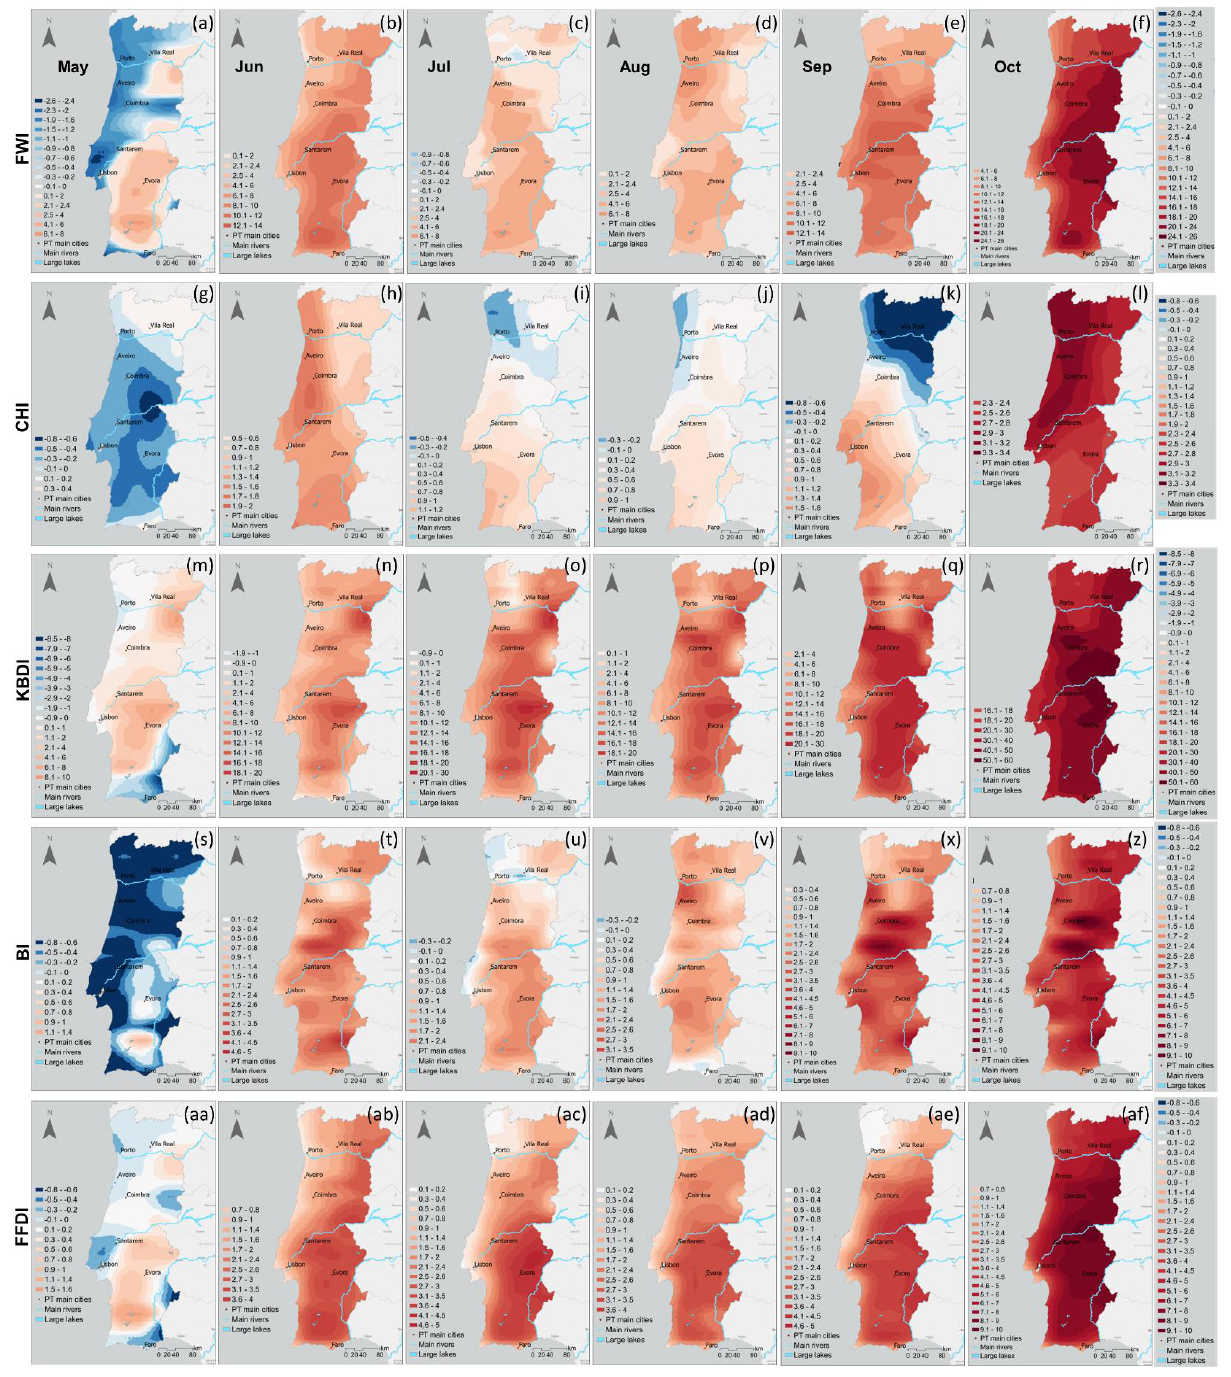
Figure 3. Spatial distribution of the statistically significant (at a 5% significance level) monthly mean anomalies for FWI, CHI, KBDI, BI, and FFDI between 2001–2021 (reference period), respectively by row and 2017 for ( a , g , m , s , aa ) May, ( b , h , n , t , ab ) June, ( c , i , o , u , ac ) July, ( d , j , p , v , ad ) August, ( e , k,q , x , ae ) September, and ( f , l , r , z , af ) October (Note that the MWW test was performed point-by-point at a 5% significance level).